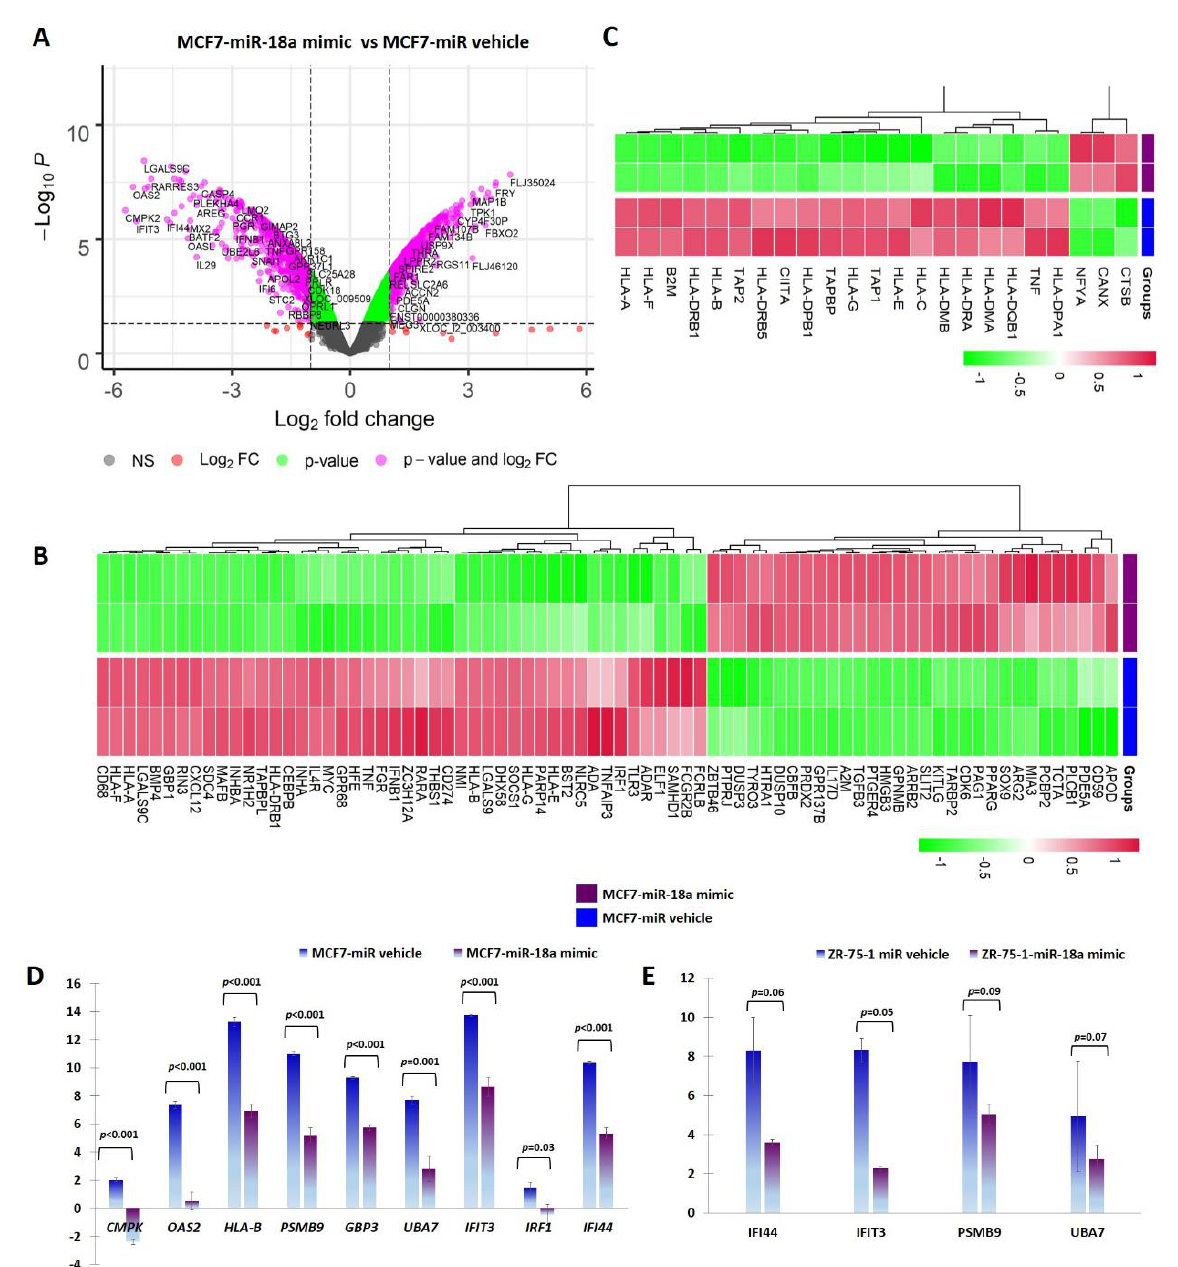
Figure 1. miR-18a over-expression mediates immune suppression in MCF7 and ZR-75-1. ( A ) Differentially expressed genes in MCF7-miR-18a-mimic vs. MCF7-negative control as obtained from microarray analysis. ( B ) Heat map demonstrating expression of immune-related gene signature in MCF7-miR-18a-mimic vs. MCF7-miR vehicle. ( C ) Heat map demonstrating expression pattern of genes regulating antigen presentation in MCF7-miR-18a-mimic vs. MCF7-miR vehicle. ( D ) q-PCR validation of down-regulation of representative immune-related genes in MCF7-miR-18a-mimic compared to MCF7-negative control. ( E ) q-PCR validation of down-regulation of representative immune-related genes in ZR-75-1-miR-18a-mimic compared to ZR-75-1-negative control. Values are mean ± S.E.M. ( n = 3). Statistical analysis was performed by the Student’s t-test compared with the scrambled negative